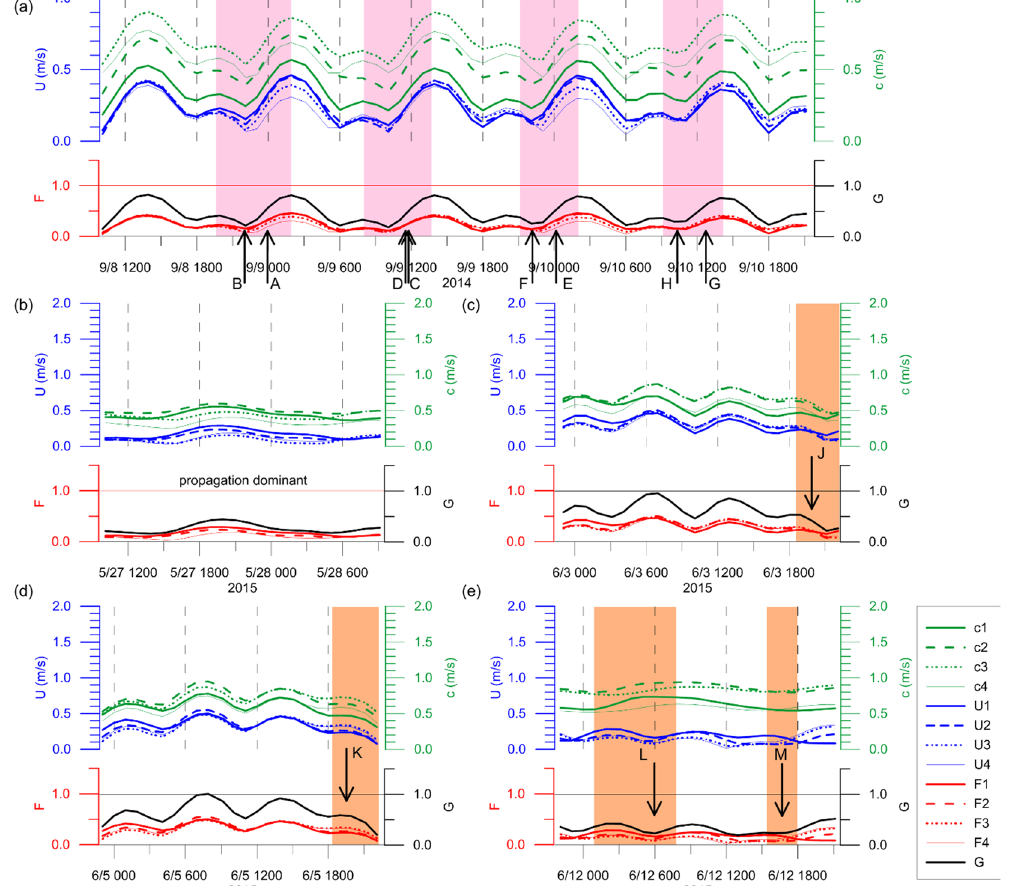
Figure 3. Time series of the advective flow speeds (U), apparent free wave speeds ( c ), and corresponding Froude numbers (F and G). Time series of the advective flow speeds (blue), apparent free wave speeds (green), and corresponding Froude numbers (red) and composite Froude numbers (black) ( a ) from 10:00 UTC September 8 to 22:00 UTC September 10, 2014, ( b ) from 10:00:00 UTC May 27 to 10:00:00 UTC May 28, 2015, ( c ) from 22:00:00 UTC June 2 to 22:00:00 UTC June 3, 2015, ( d ) from 22:00:00 UTC June 4 to 22:00:00 UTC June 5, 2015, and ( e ) from 22:00:00 UTC June 11 to 22:00:00 UTC June 12, 2015. Vertical arrow with labels corresponding to the NIW fronts shown in Fig. 1f indicates when the free wave propagation was favorably initiated or NIW front is presumably formed to fit the SAR observations, which generally correspond to periods of small Froude number (G; thick solid black). Significant decreases in the Froude number to yield subcritical conditions are remarked with pink and orange